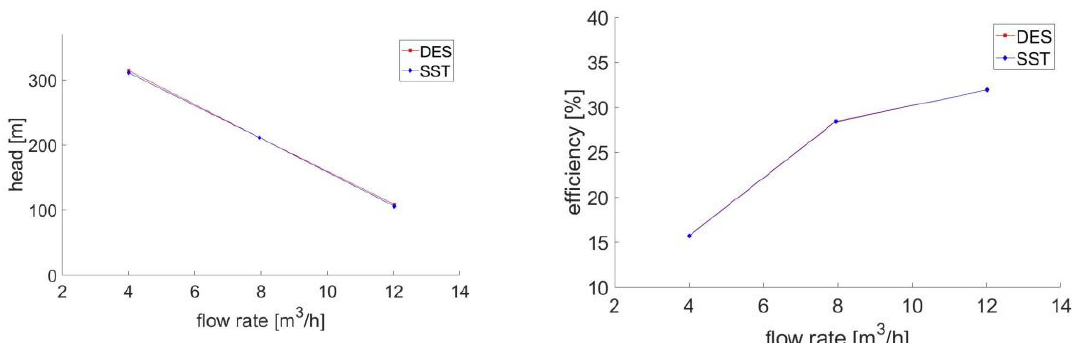
Table 3. Hydraulic performance of the SST and DES models at different flow points.